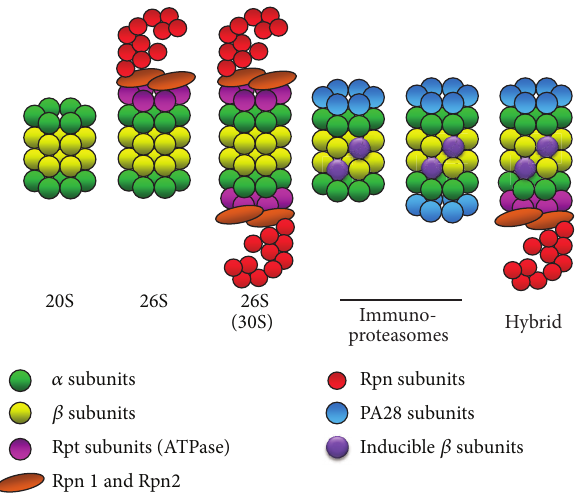
Figure 3: Schematic diagram of different forms of the proteasome. Intracellular proteasome exists in different forms. The 26S pro- teasome can exist with one or two 19S caps, immunoproteasomes containing one or two 11S caps, proteasomes containing the 20S proteasome with one or two PA200 caps (in the nucleus only), and hybrid proteasomes which contain different combinations of 20S and